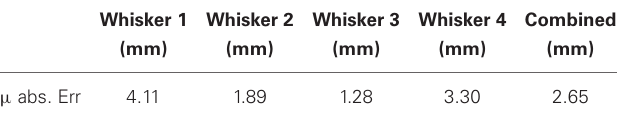
in Figure 11 . Mean absolute error for radial distance estimation is shown in Table below.